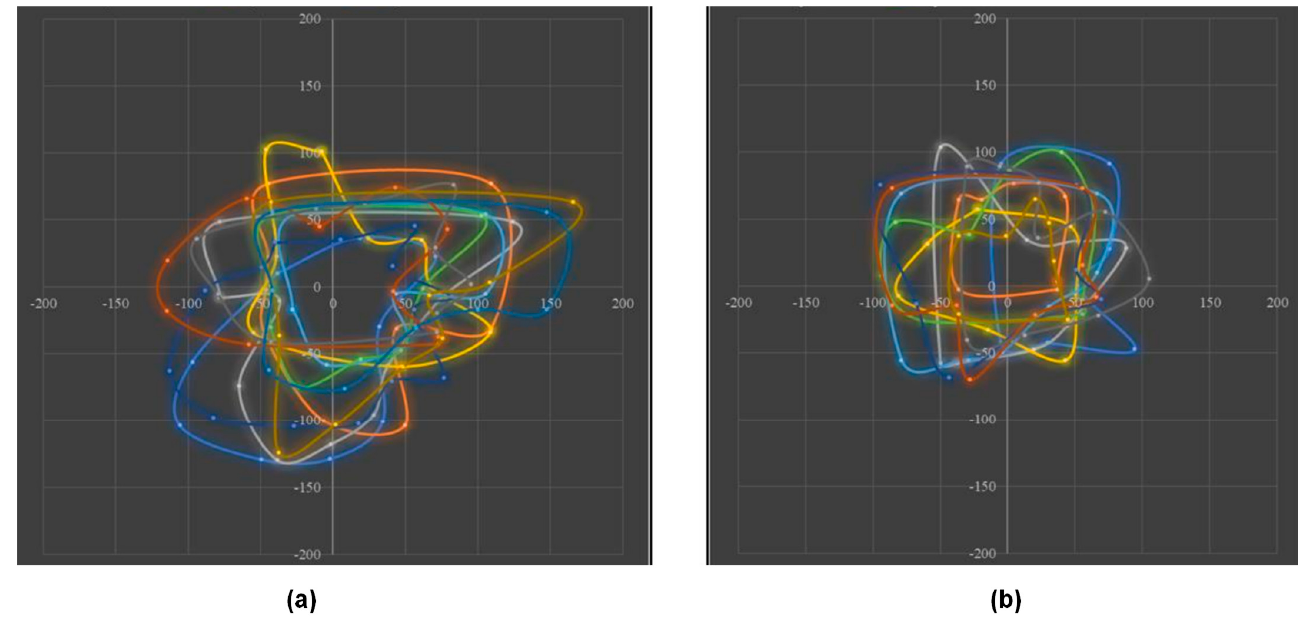
Figure 4. Bound graph represent the space used by a passenger with reduced mobility: ( a ) user with a pram; ( b ) wheelchair user. Coordinates are in cm.